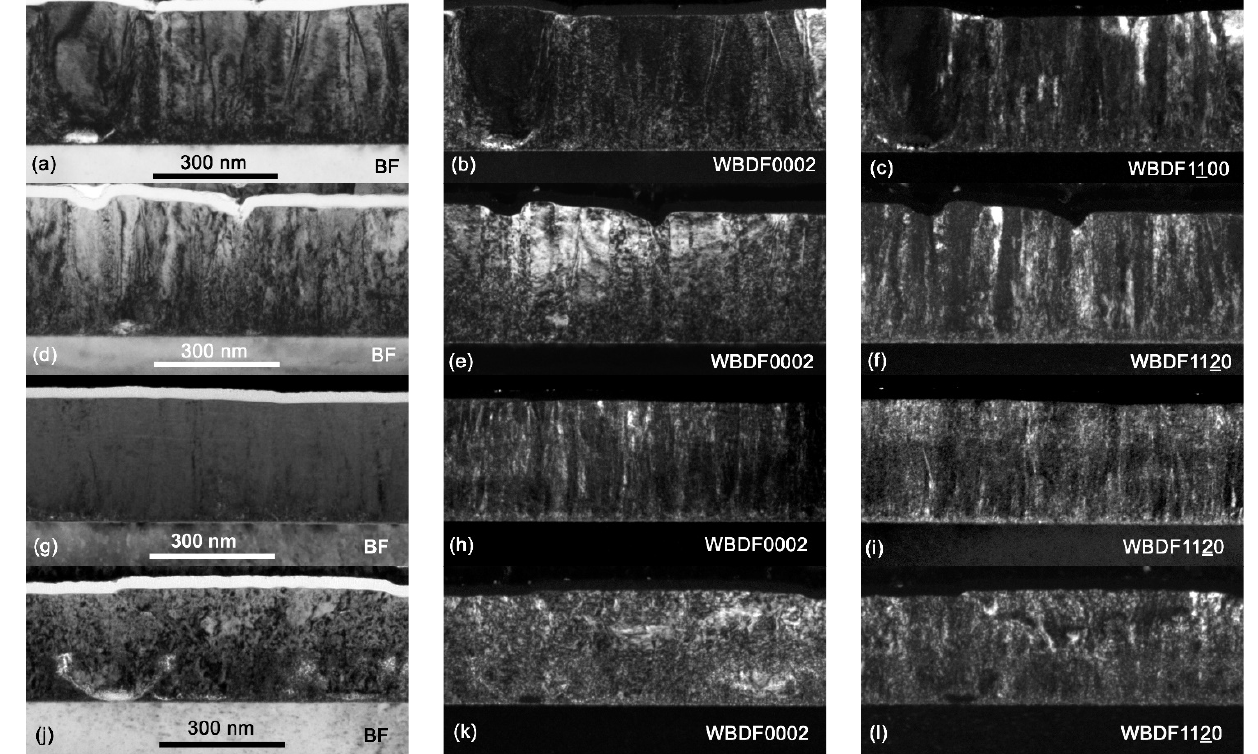
Figure 5. InAlN layers TEM analysis for Cp 2 Mg flow of ( a – c ) 0 nmol/min, ( d – f ) 30 nmol/min, ( g – i ) 80 nmol/min, ( j – l ) 130 nmol/min. The images are taken as bright field (BF) or weak beam dark field (WBDF) images using diffraction beams indicated in the images.